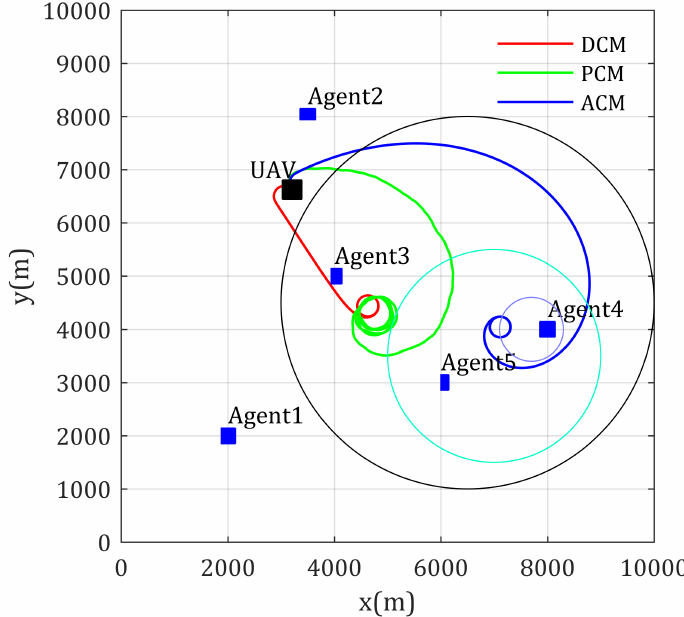
Figure 8. Paths for multi-static-agents-inter communication with known channel